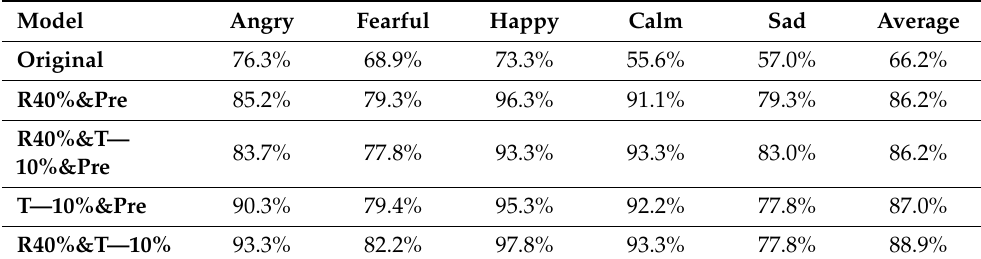
Table 5. Mixed adjustment data test results.